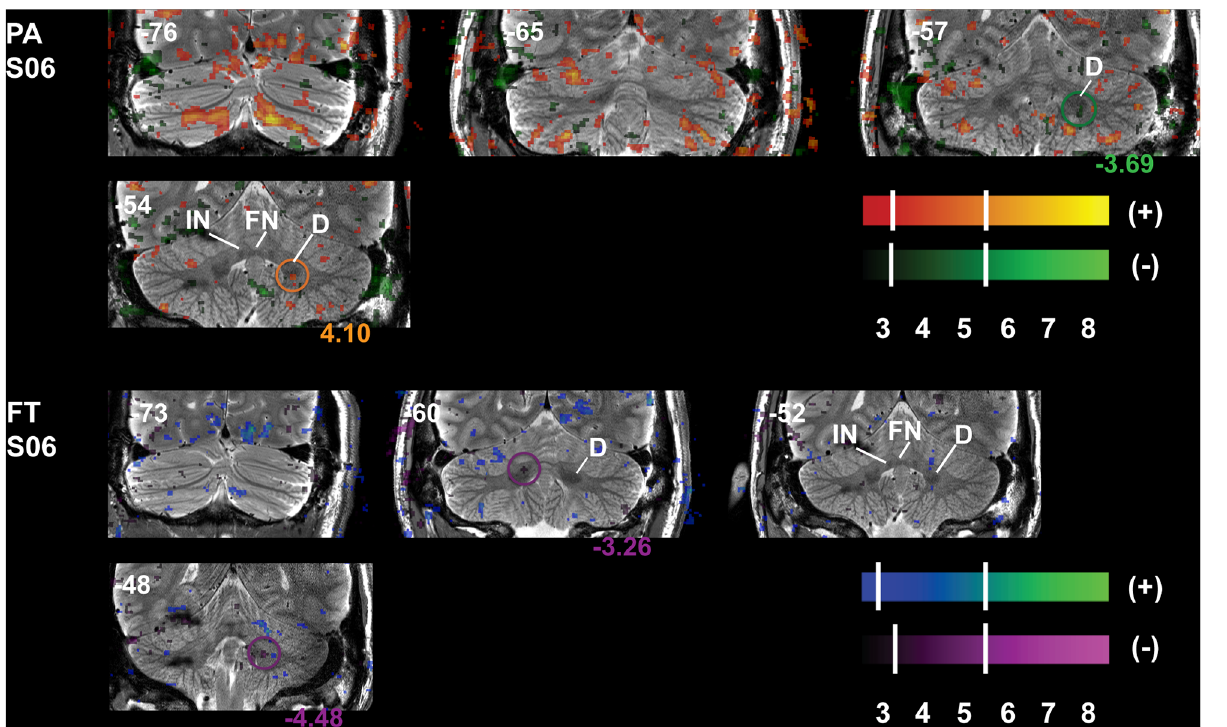
Fig 7. Concomitant Correlation of Task-Related Cb Cortex Activity and Anticorrelation of DCN Activity. The detail of the T2W scan allows visualization of DCN revealing increases (+) and decreases (-) in task-related functional activity in Cb cortex and within the dentate (respectively) of a single subject. Correlation of task-related activity (+) in the Cb cortex is concomitant with anticorrelation of activity (-) in the dentate and that cognitive depression (PA, green at -57) is located more caudal in the dentate than (the stronger) motor depression (FT, purple at -48). Slice locations (in non-normalized MNI space) are displayed at the top of each panel and maximum T-values from clusters within the circles are displayed at the bottom of the panels; coloring matching the respective color bar. Refer to Fig 1a for a guide to anatomical lobule definitions. FN — fastigial nucleus, IN — interpositus nucleus, D — dentate